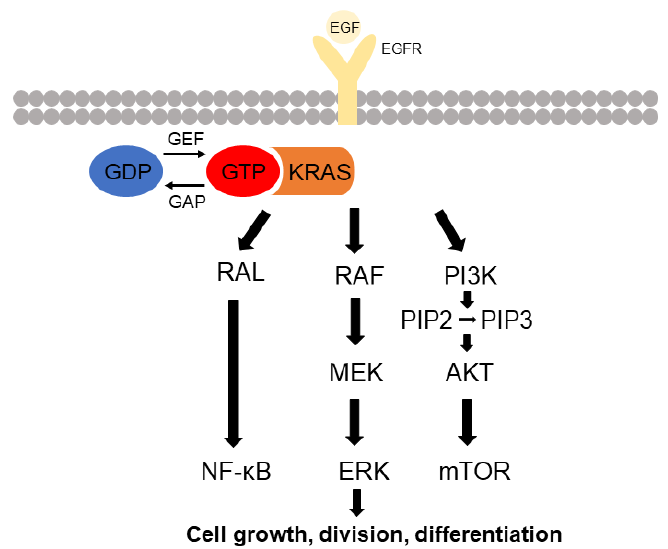
Figure 4. Signaling pathway of KRAS protein. Activation of RAS occurs when epidermal growth factor (EGF) binds to tyrosine kinases receptor such as epidermal growth factor receptor (EGFR). KRAS protein is activated by binding to GTP, transducing the cytoplasmic signal, which activates the RAL, RAF-MEK-ERK, and PI3K-AKT cascade. These cascades regulate cell growth, division, and